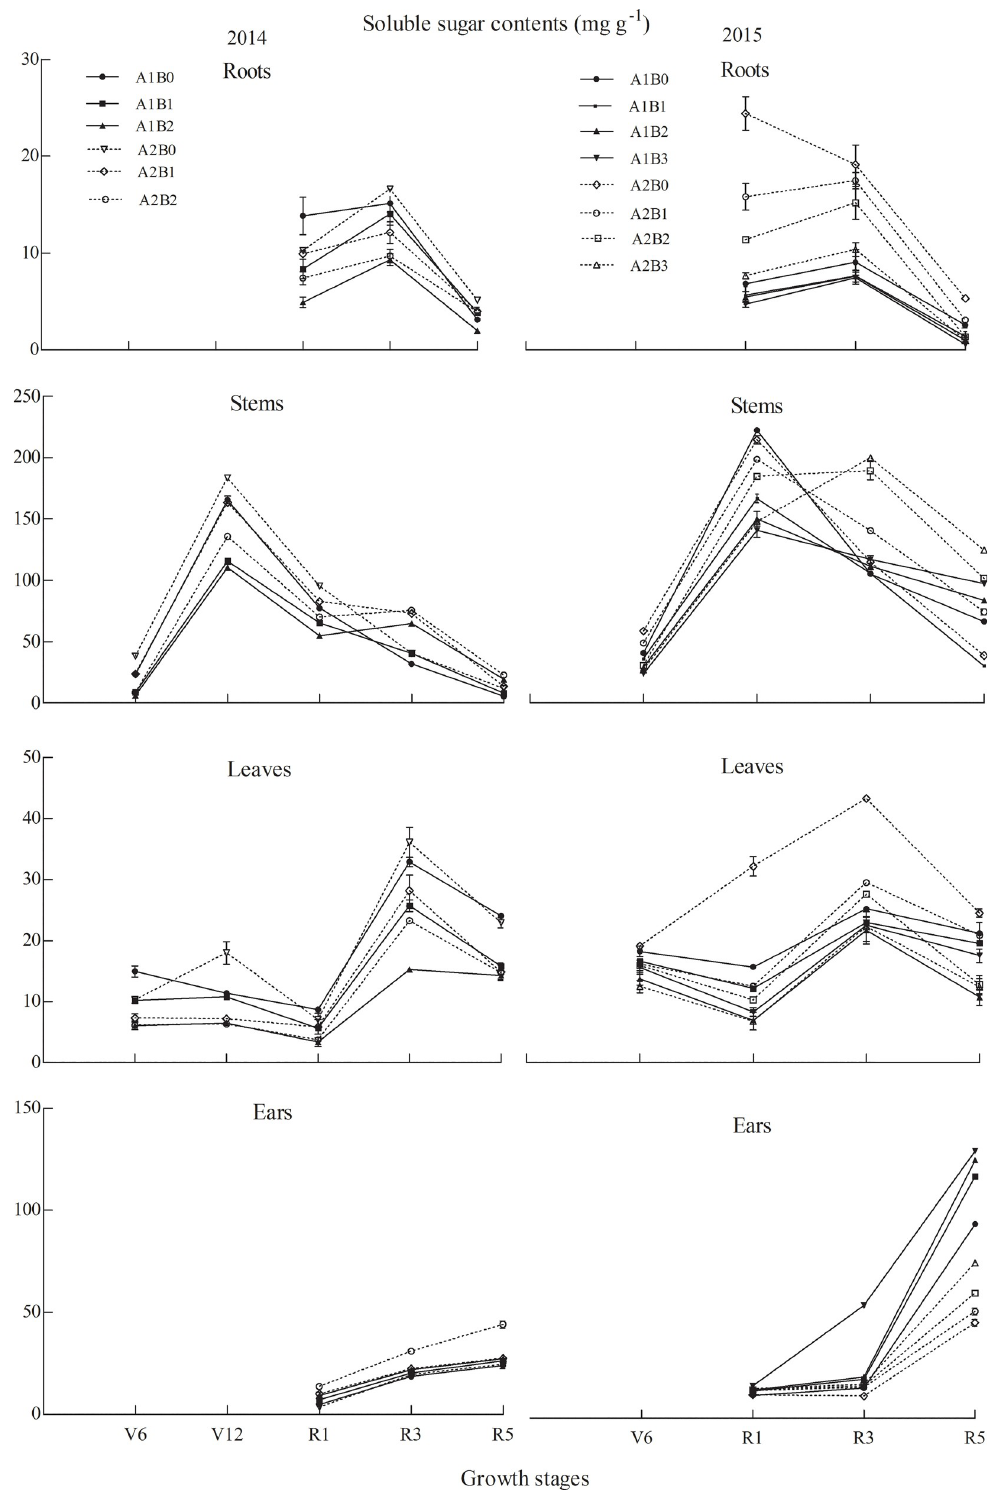
Fig 3. Soluble sugar content in different growth periods of maize under various treatments. Note: V6, jointing (V6); V12, big trumpet; R1, silking (R1); R3, milk-ripe; and R5, maturity. A stands for cultivars: A1, ZH311; A2, XY508. B stands for N treatments: B0, 0 kg � ha -1 ; B1, 150 kg � ha -1 ; B2, 300 kg � ha -1 ; and B3, 450 kg � ha -1 .The point in R5 indicates soluble sugar content in grains.